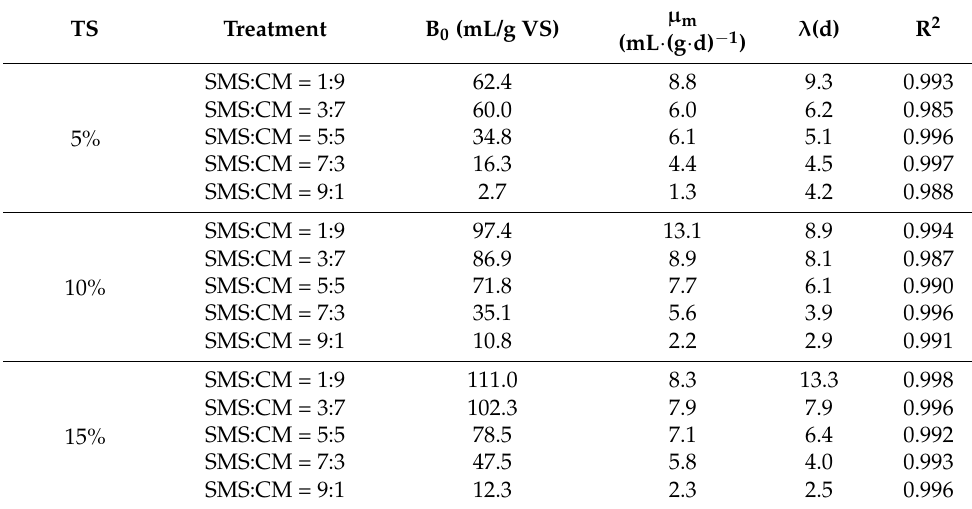
Table 4. Result of the kinetic study.